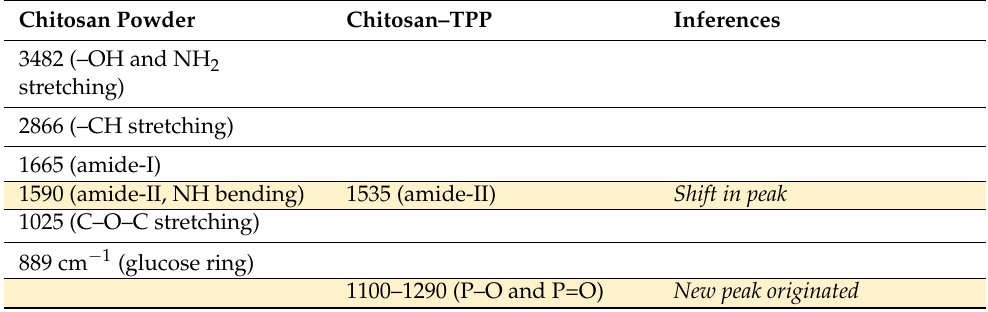
Table 2. Characterization of FTIR spectra of chitosan powder with chitosan-TPP